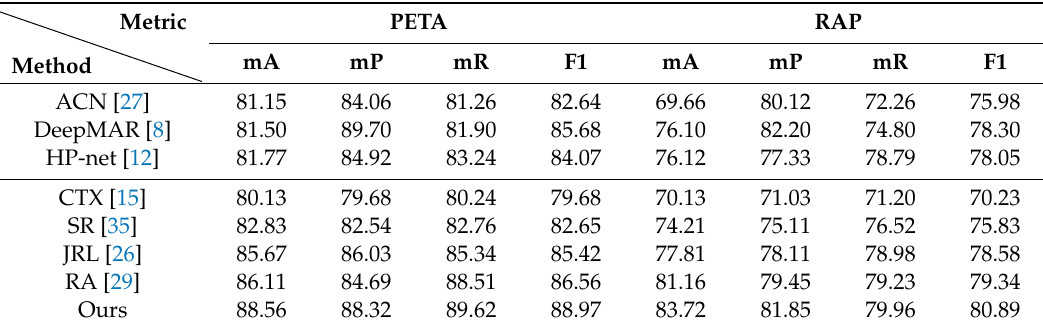
Table 1. Comparison with state-of-the-art (SOTA) methods on the PETA and RAP